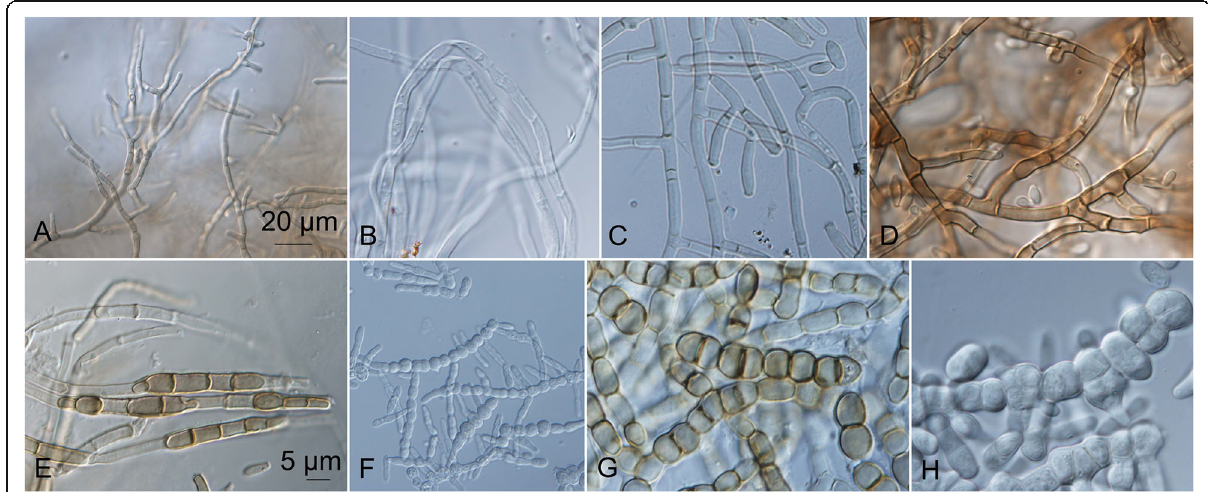
Fig. 11 Different kinds of non-sporulating mycelium produced by Hortaea werneckii cultures after 14 days at 25 °C. a EXF-561: PDA, immersed margin. b EXF-161: oatmeal agar (OA), aerial margin. c EXF-171: potato dextrose agar (PDA), aerial. d EXF-4493: malt extract agar (MEA), immersed centre. e EXF-11537: OA, immersed margin. f EXF-2682: PDA, centre. g EXF-2690: OA, margin. h . EXF-2682: MEA + 10% NaCl, centre. Bar = 20 μ m ( a , f ), 5 μ m ( b-e , g-h